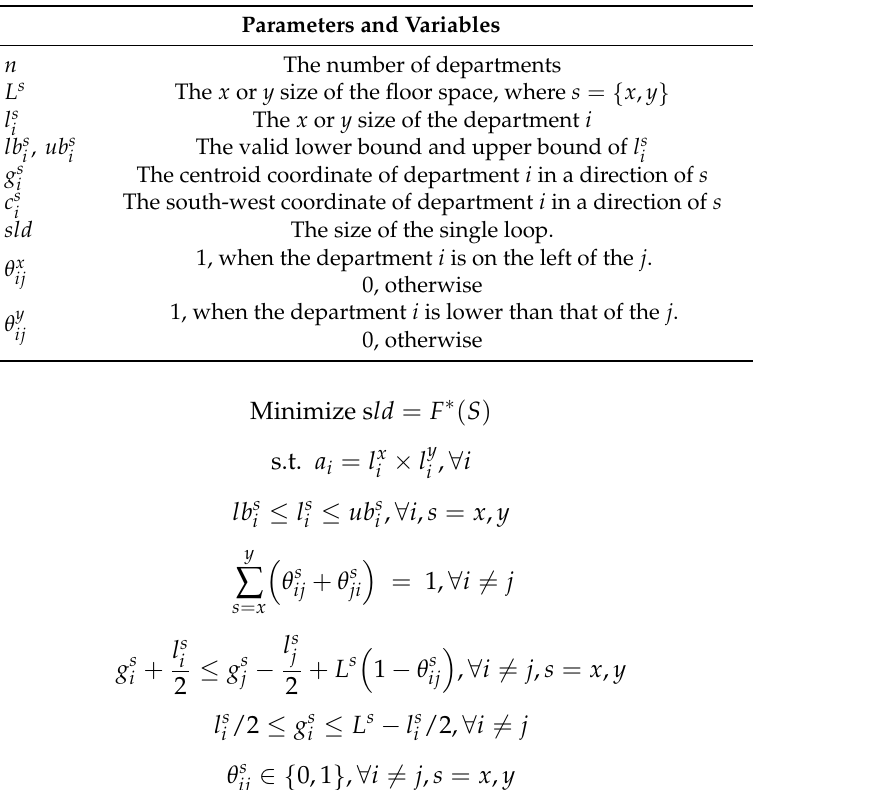
Table 1. Parameters and